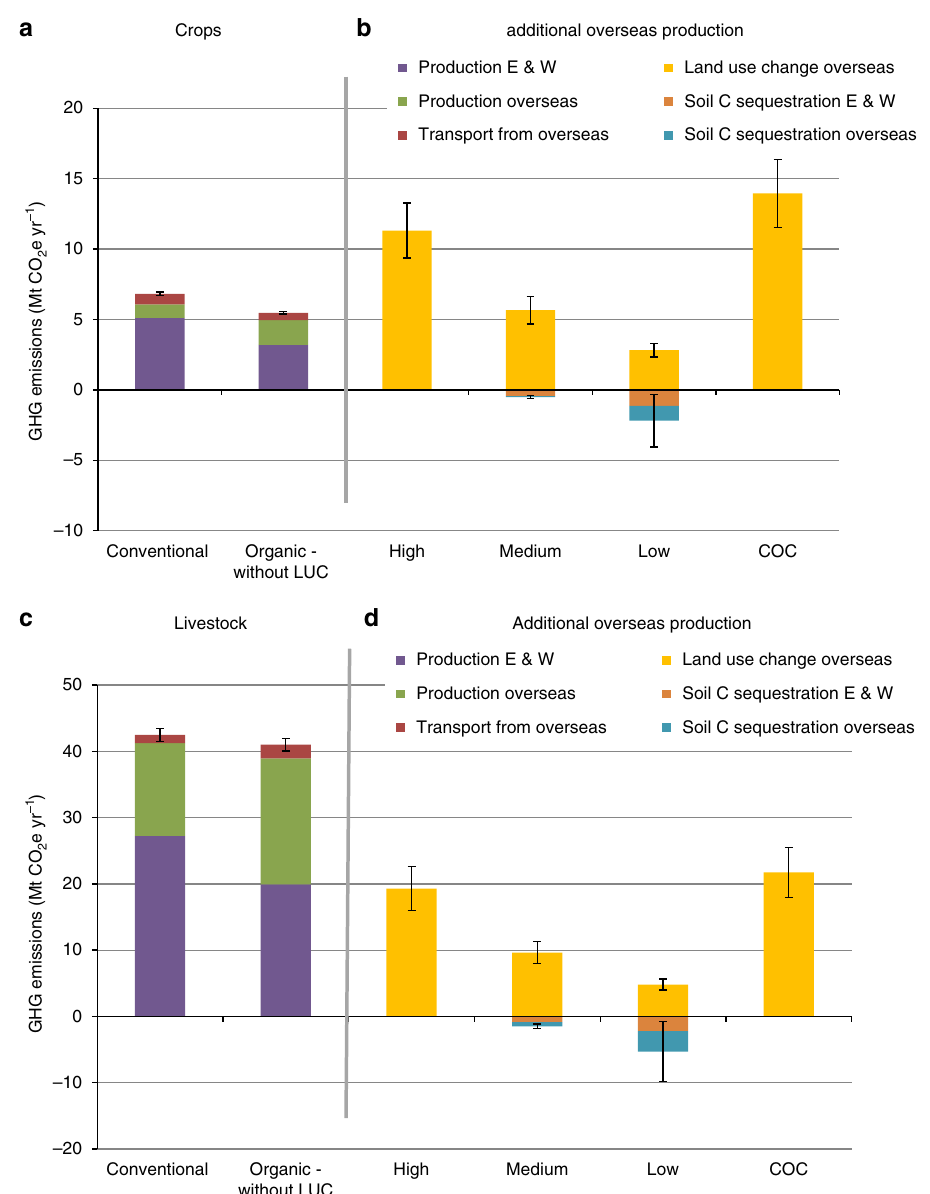
Fig. 3 Total GHG emissions from food production for England and Wales (E & W) under conventional and organic farming methods. a For food crops for human consumption both from home and overseas production. b Additional net emissions due to soil C sequestration (CS) and overseas land use changes (LUC) to compensate for shortfalls in home production: High = all LUC by conversion from grassland, no CS; Medium = 50% of LUC by conversion from grassland, moderate CS; Low = 25% of LUC by conversion from grassland, high CS; COC = carbon opportunity cost of Searchinger et al. 35 (Methods). c For livestock both from home and overseas production, including emissions during production of crops fed to livestock. d Additional net emissions due to CS and overseas LUC to compensate for shortfalls in livestock production: High, Medium, Low as for Crops. Note LUC losses and CS gains both only apply over the fi rst few decades following conversion, however a fl at rate is applied here. Data are means ±1 standard deviation from the uncertainty analysis (Methods). Source Data are provided as a Source Data fi